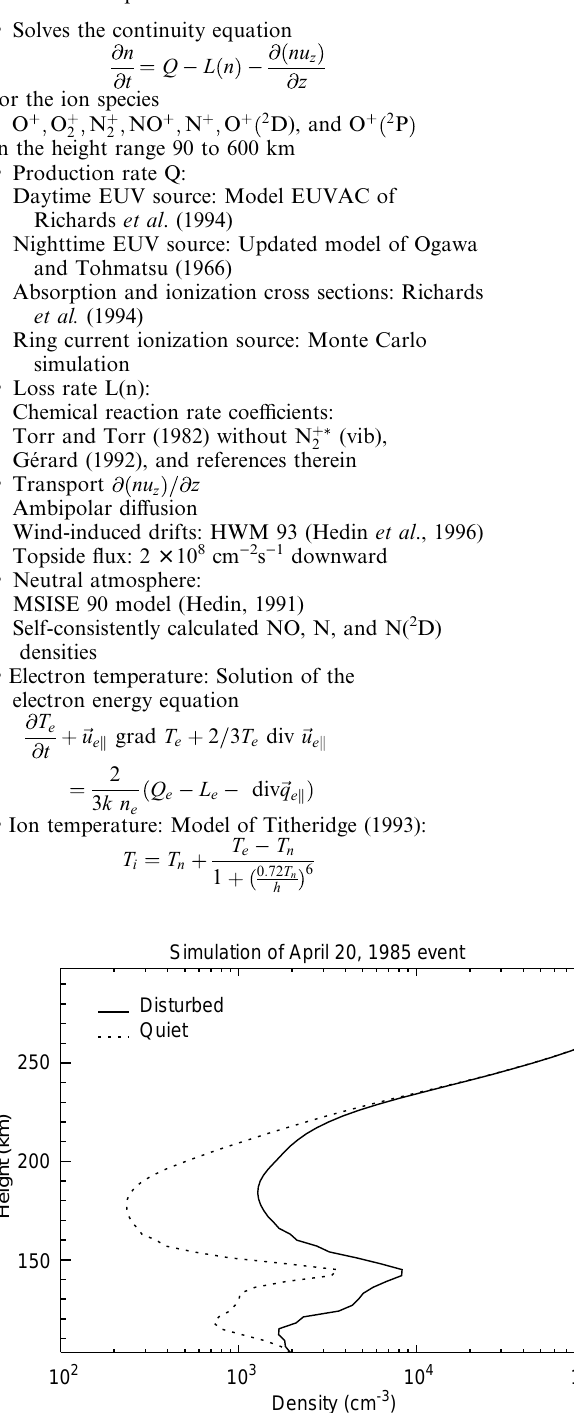
Table 1. Ionospheric